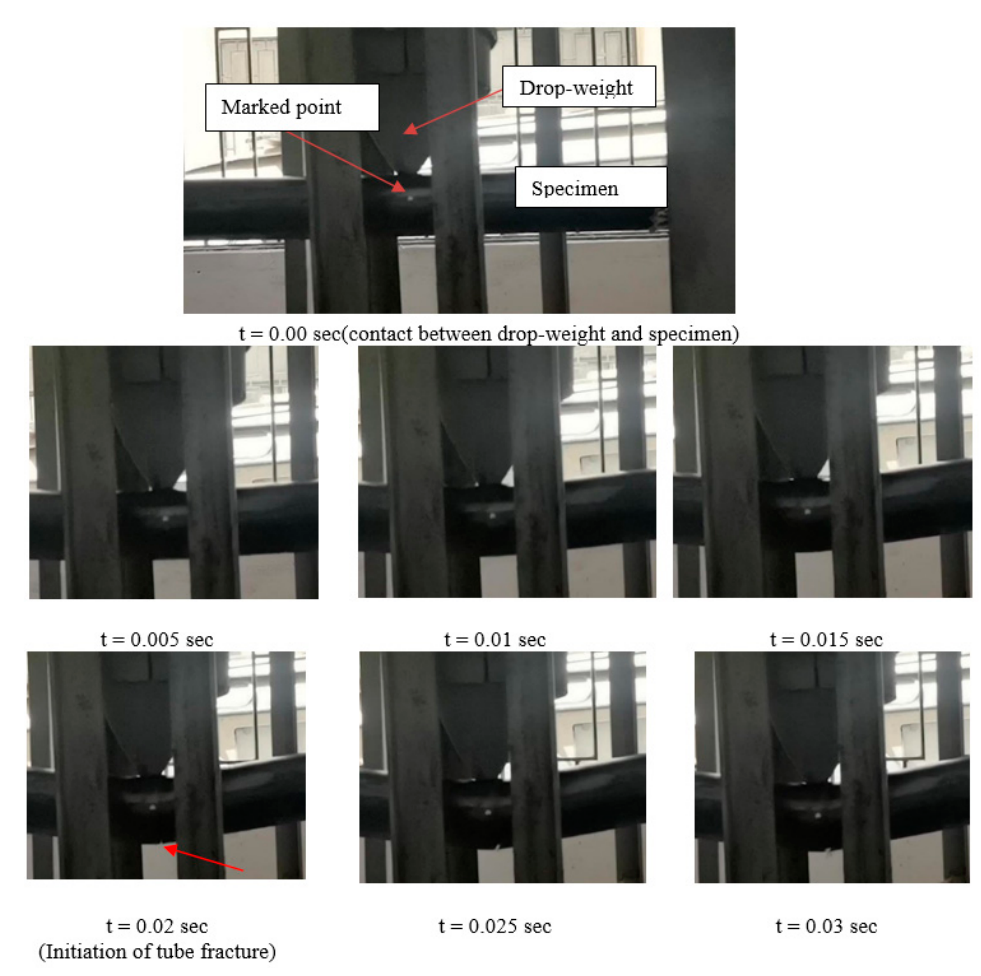
Figure 6. Test and failure of specimen NC-M2-H2.